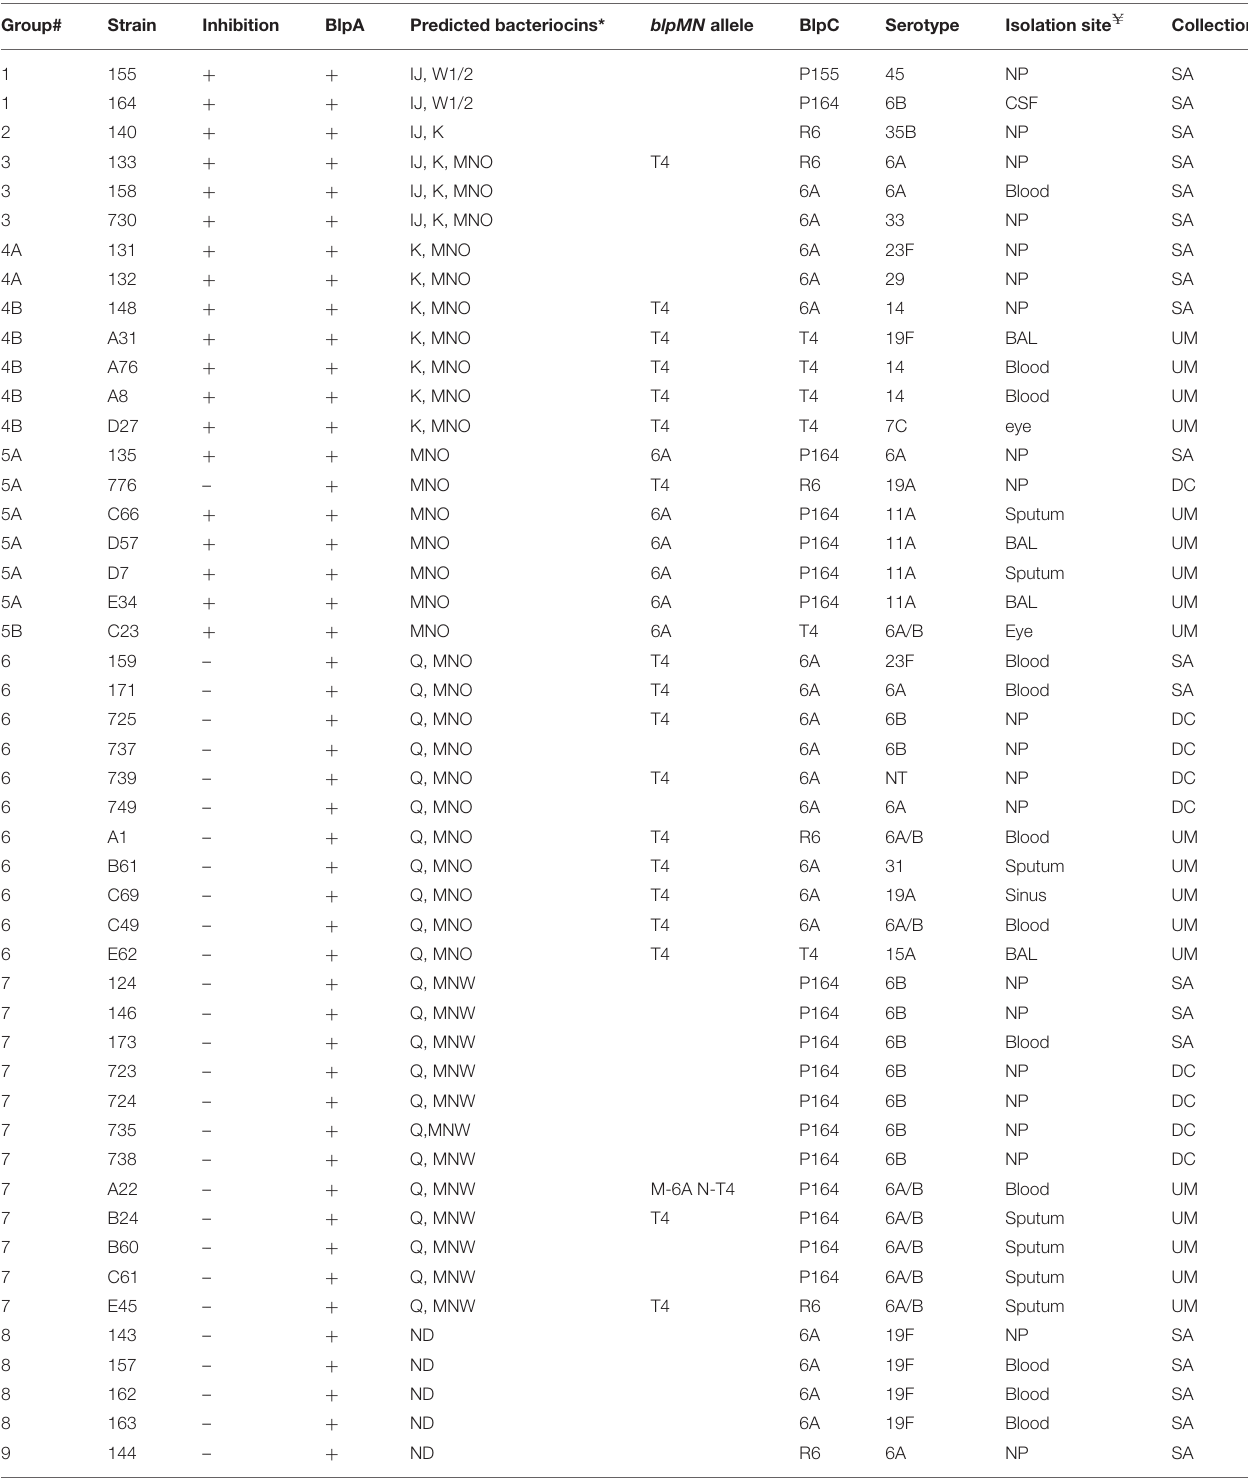
TABLE 2 | Characteristic of strains with active blp loci identified from clinical and colonizing isolate collections. Group# Strain Inhibition BlpA Predicted bacteriocins* blpMN allele BlpC